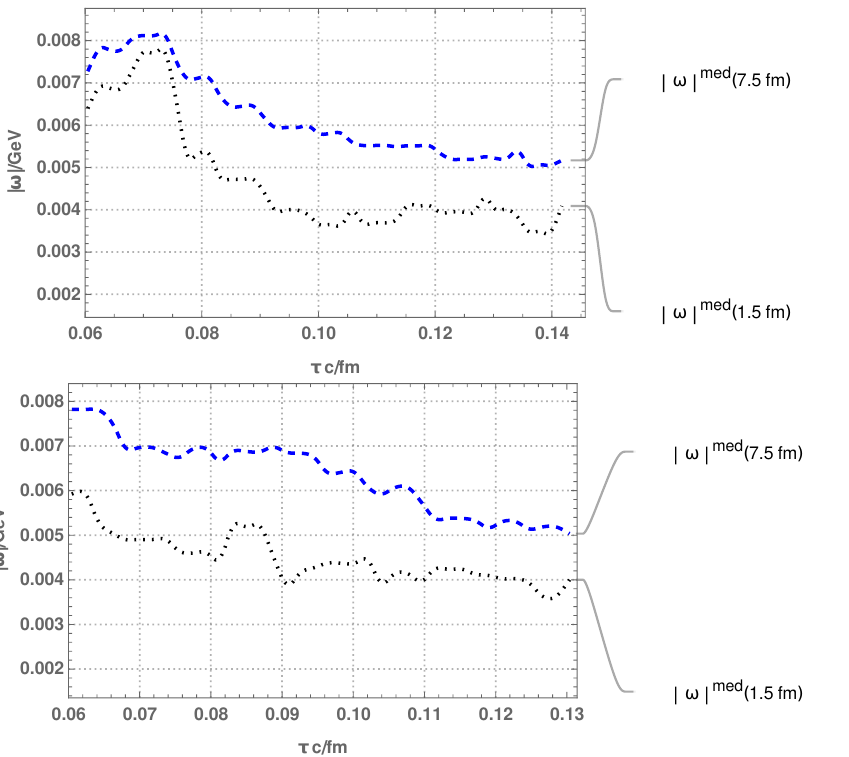
Figure 11 . In the top plot we show the median absolute value of the three vector vorticity | ~ω | , given by the spatial components of (4.6) at rapidity ξ = 0 . The black dotted line shows the vorticity averaged over the central region | x ⊥ | < 7 . 5 fm, whereas the blue dashed curve shows the same for | x ⊥ | < 1 . 5 fm. The plot below depicts the analogous functions at rapidity ξ = 0 . 25 . Even at proper times the average vorticity in the central, low rapidity region is only about 2% of the peak vorticity.